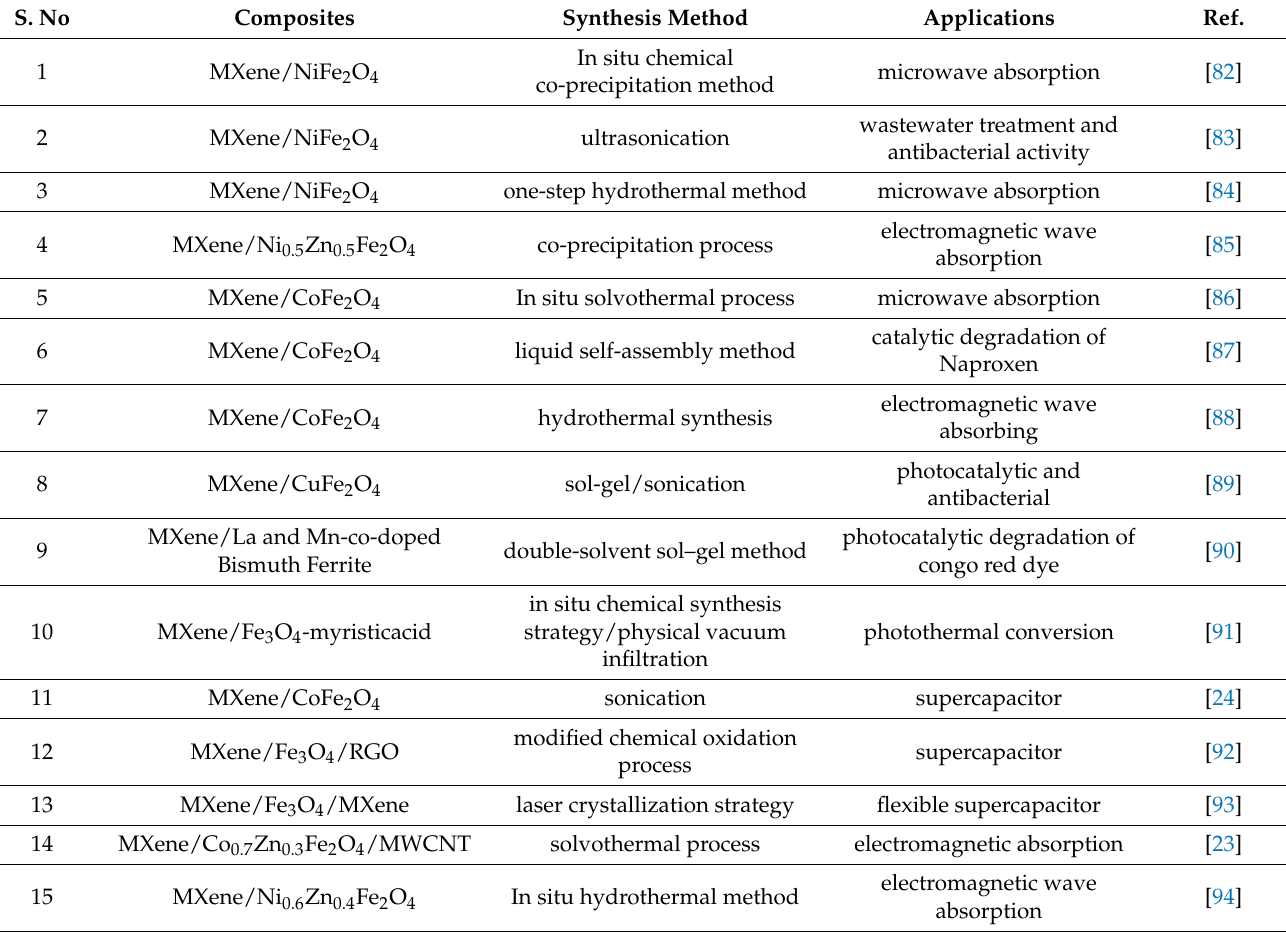
Table 2. MXene composites and their applications.